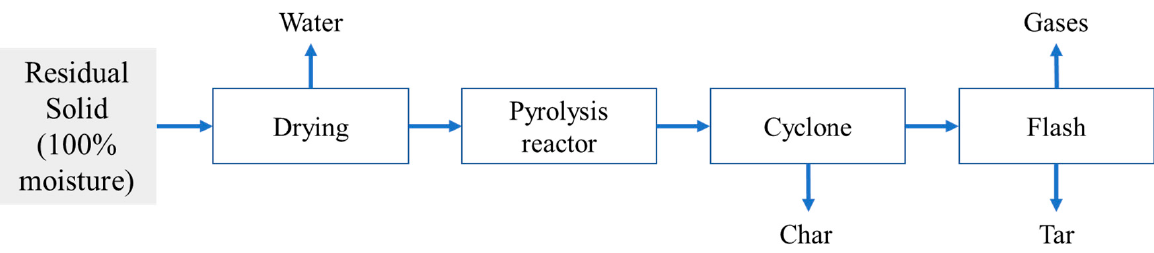
Figure 4. Process flow for solid conversion through the pyrolysis process.